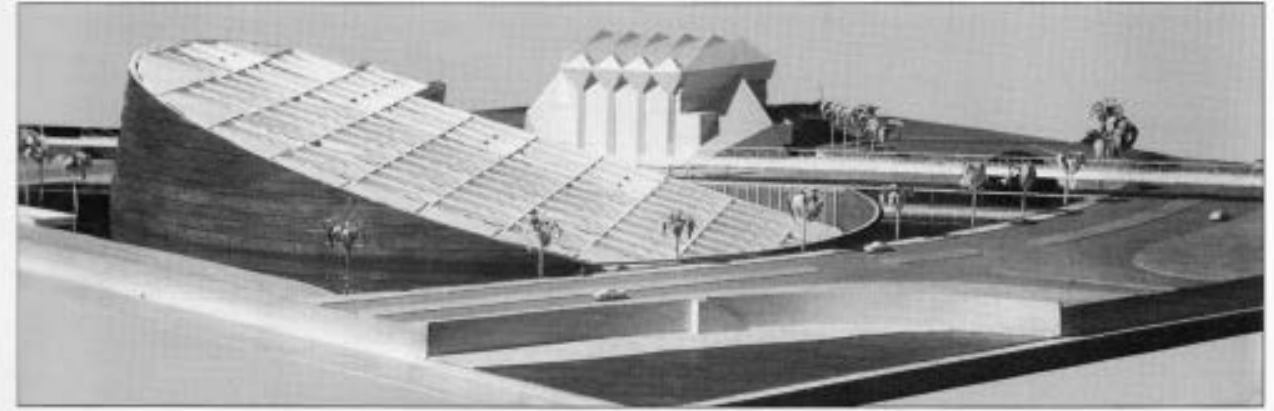
Figure 3 Model of the New Alexandrina project, showing the library building and exhibition space in the foreground and the con­ :erence centre beyond.